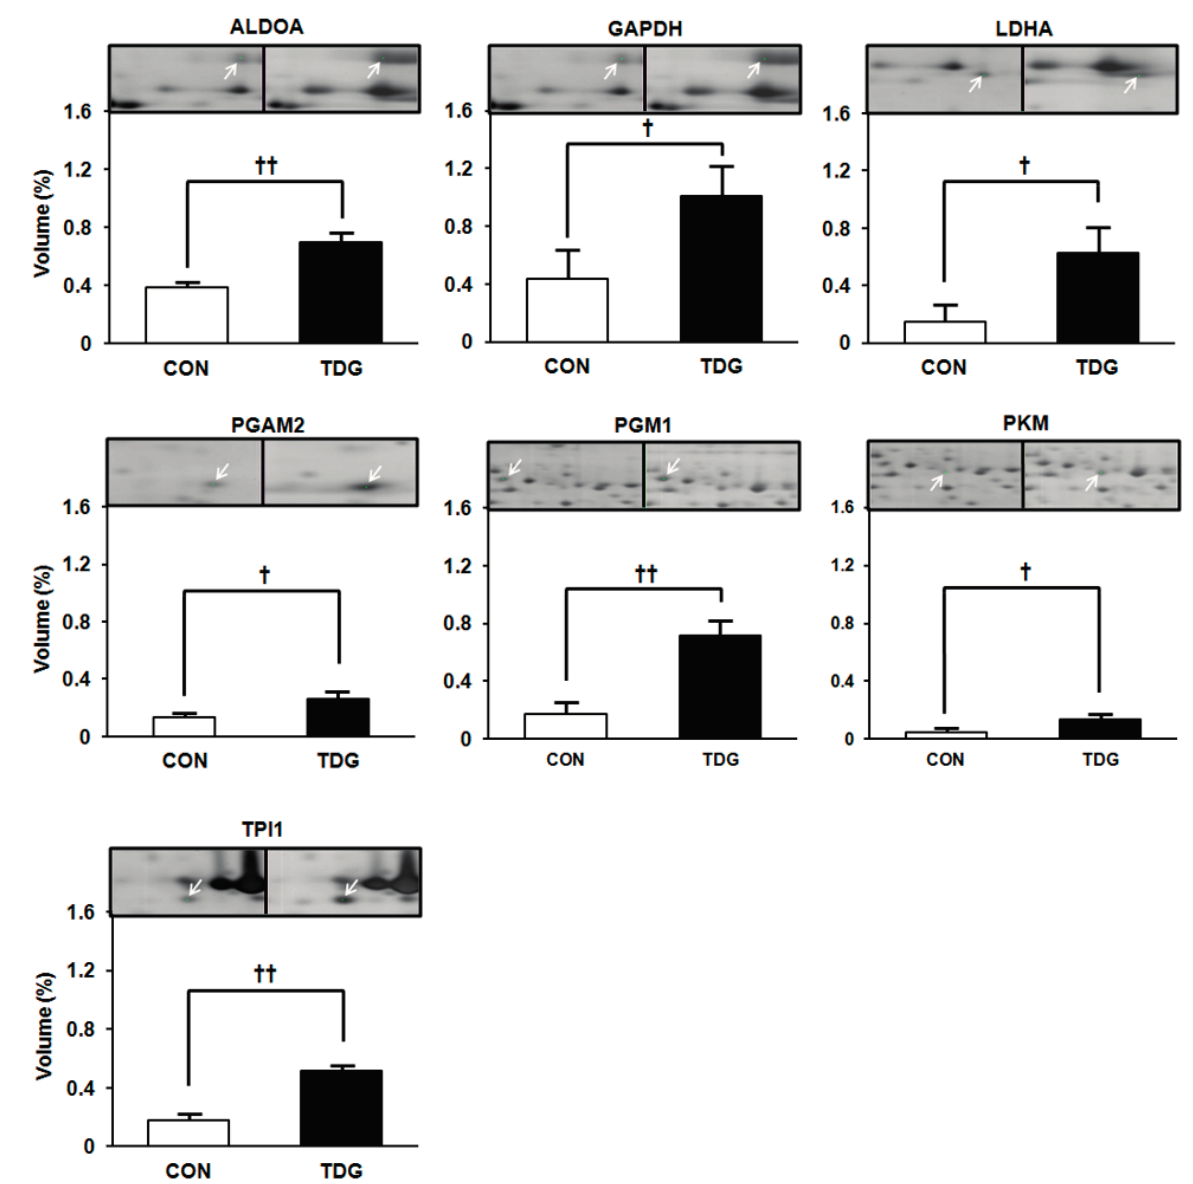
Figure 3. WAT proteins involved in carbohydrate metabolism showing differential regulation between control (CON) and TDG-treated (TDG) groups. Band intensity was measured by ImageMaster 2-DE software version 4.95. Data are presented as the mean ± SD of volume density (%) of altered proteins in pooled samples from six rats in each group. Statistical significance between the control and TDG-treated groups was estimated by Student’s t -test, where p -values are † p < 0.05 and †† p < 0.01. Full names are presented